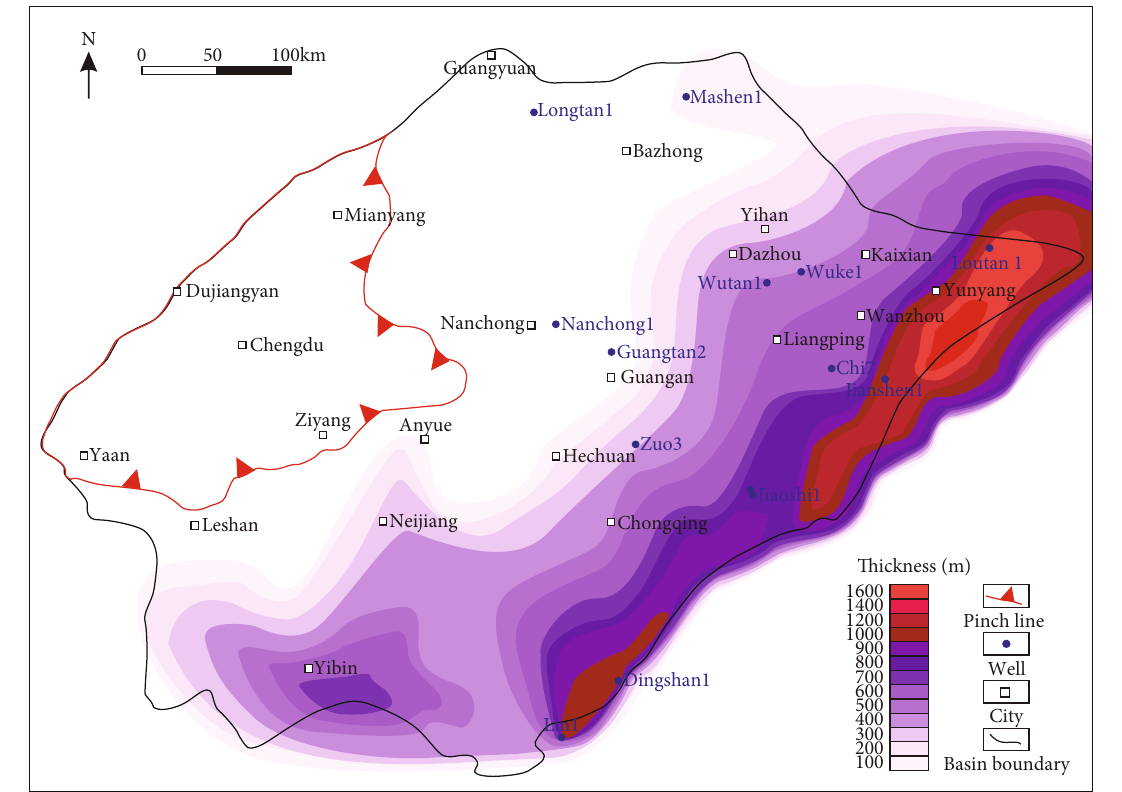
Figure 7: Residual thickness of the Cambrian DEPS in the Sichuan